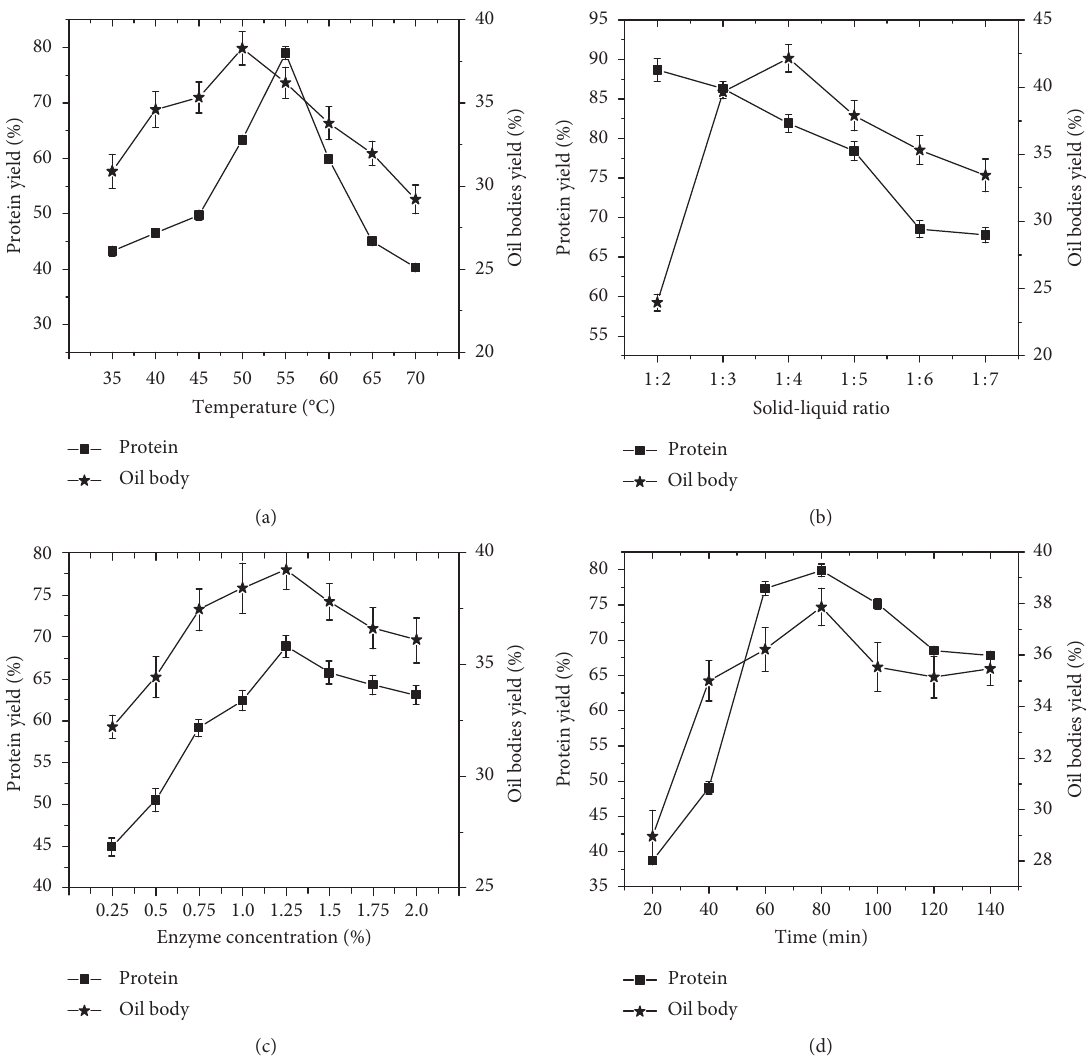
Figure 5: Effect of different enzyme hydrolysis temperature, solid-liquid ratio, enzyme concentration, and enzyme hydrolysis time on peanut protein and oil bodies